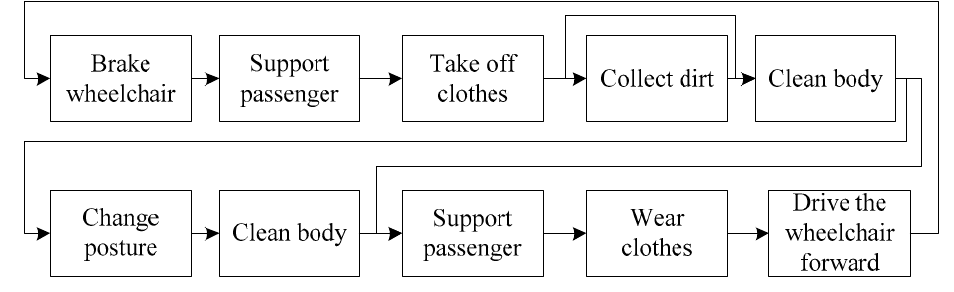
Figure 14. Function chain of the second design concept.